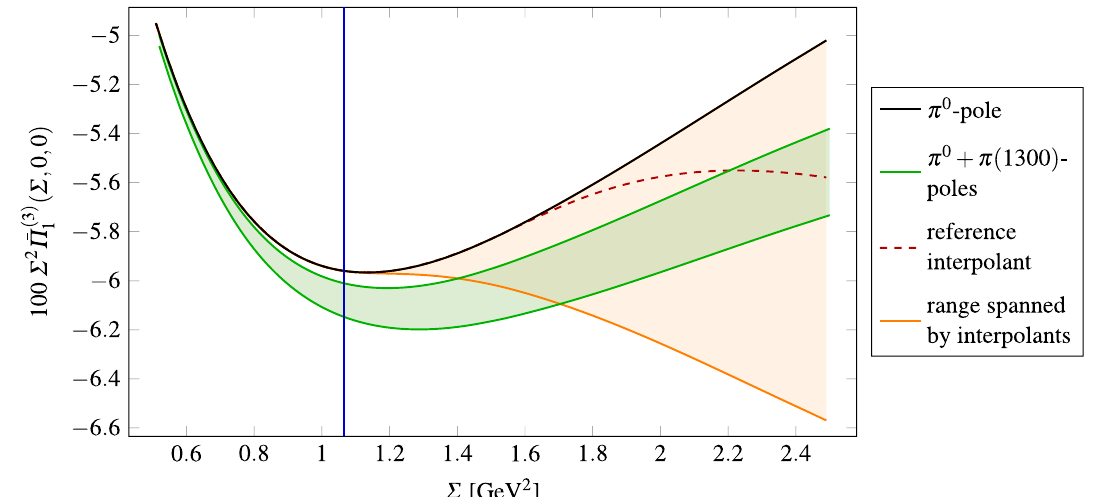
Fig. 3 The figure displays the dispersive pion pole contribution, the reference interpolant and the (orange) band corresponding to the var- ious choices of the parameter m . The blue line indicates the value of